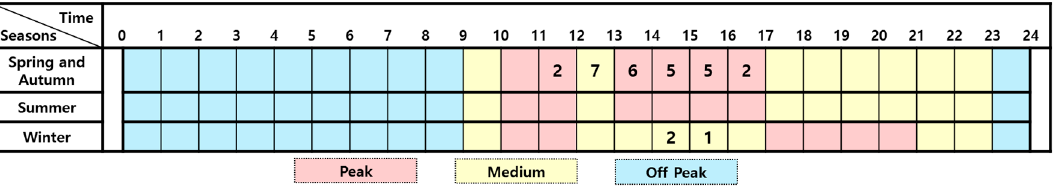
Figure 8. The number of times of estimated VRE curtailment per hour in Jeju 2022.